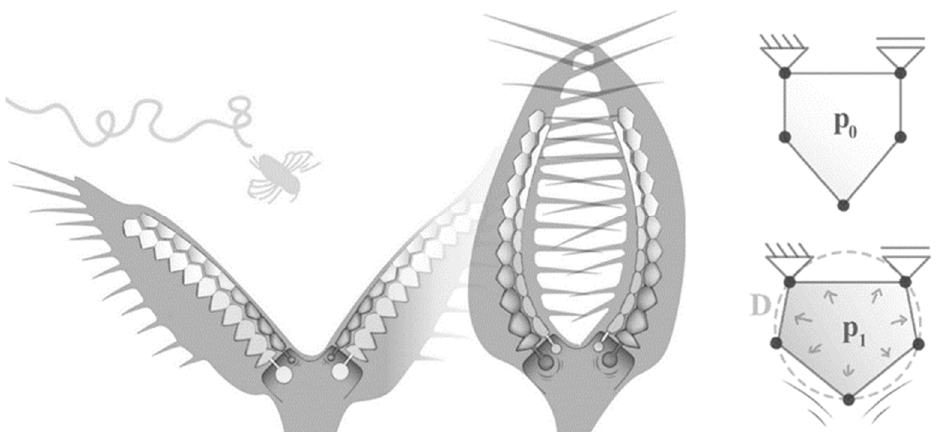
Figure 1. Schematic cross-sectional view of Venus flytrap and derived compliant mechanism of a single PACS Cell. Reprinted/adapted by permission from Springer Nature [11].